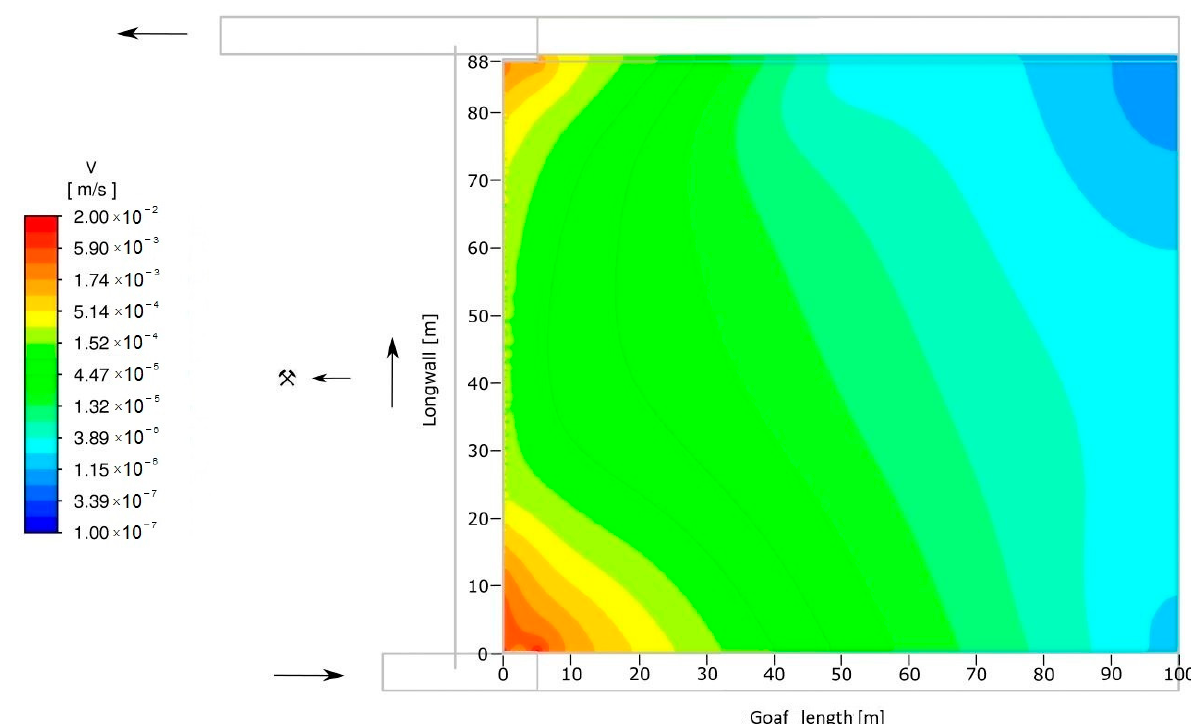
Figure 8. Velocity contours on a logarithmic scale in the range from 1.0 × 10 − 7 m/s to 0.02 m/s for a model with variable parameters of porosity and permeability in the goaf.